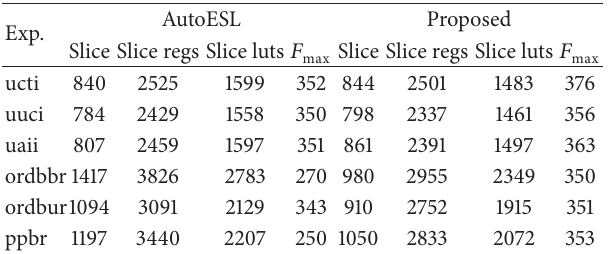
Table 5: Implementation results given by AutoESL and the pro- posed.